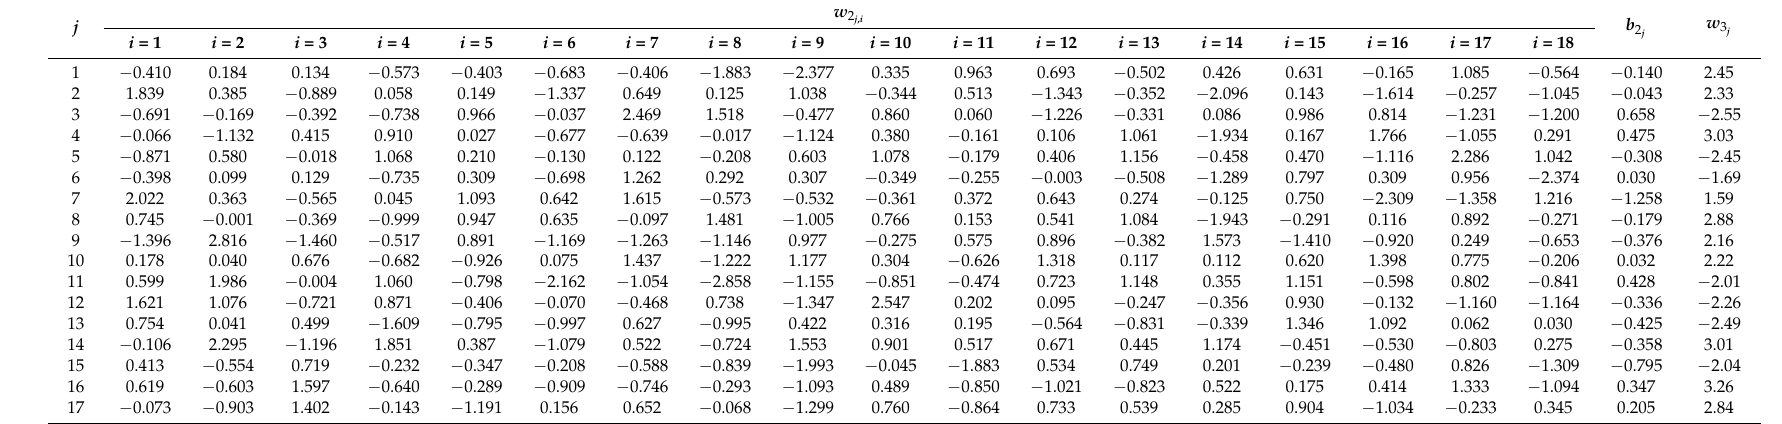
Table 3. Weights and biases of the second hidden layer in the ANN structure of the bubble point pressure